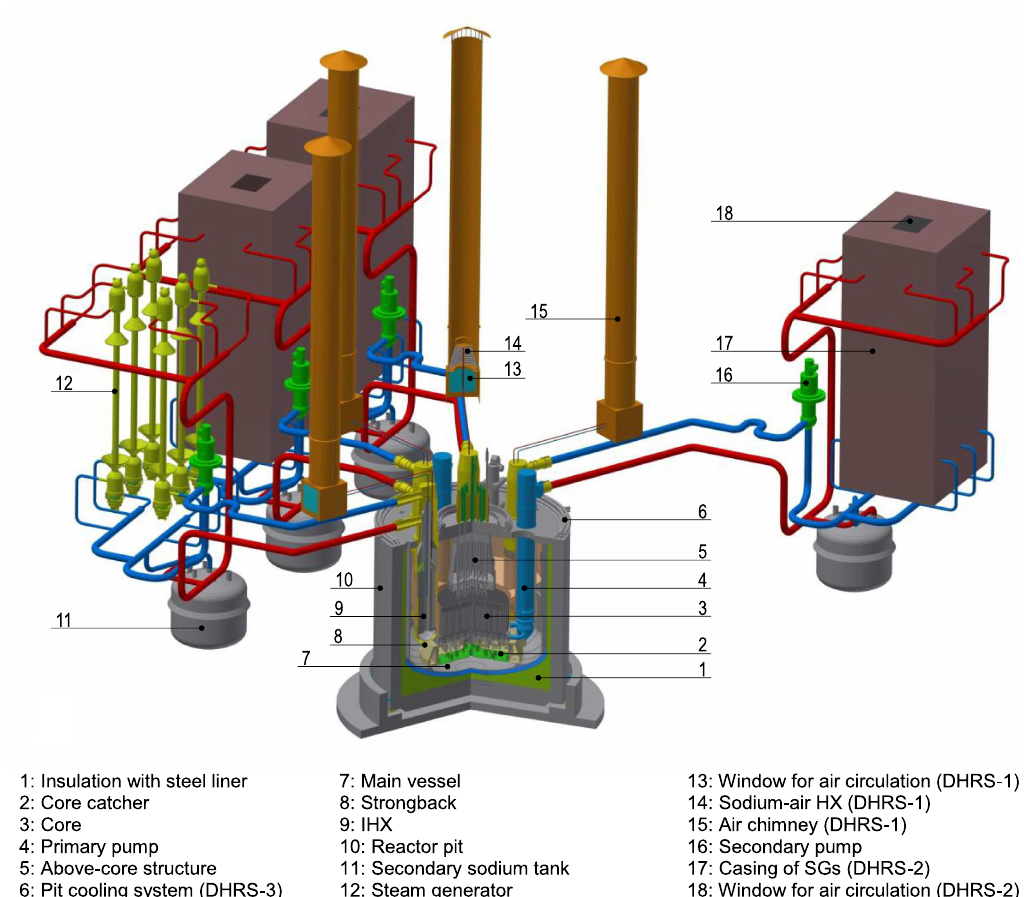
Fig. 3. General view of ESFR-SMART